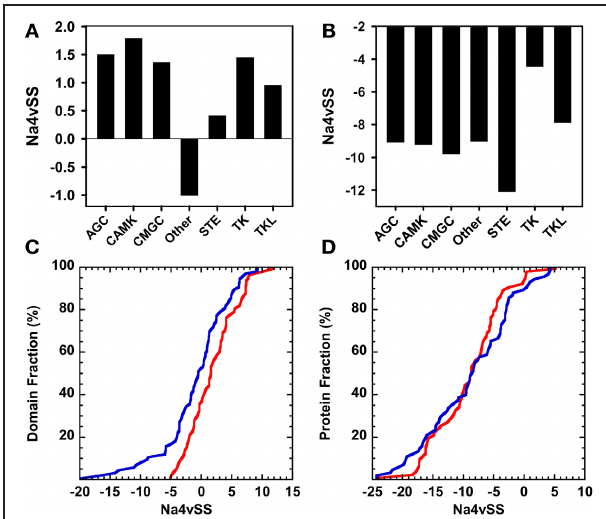
FIGURE 7 | Aggregation properties of the human kinase proteins and domains clustered according to their corresponding group (only groups composed of > 40 sequences are considered). (A) and (B) Average aggregation propensity (Na4vSS) of the sets corresponding to each group considering only domains or whole proteins, respectively. (C) and (D) Distribution of the average aggregation propensity (Na4vSS) across the sets corresponding to the domain groups that show the most opposed behavior: Other (blue) and CAMK (red). Distributions are shown for kinase domains only (C) and for whole proteins (D)